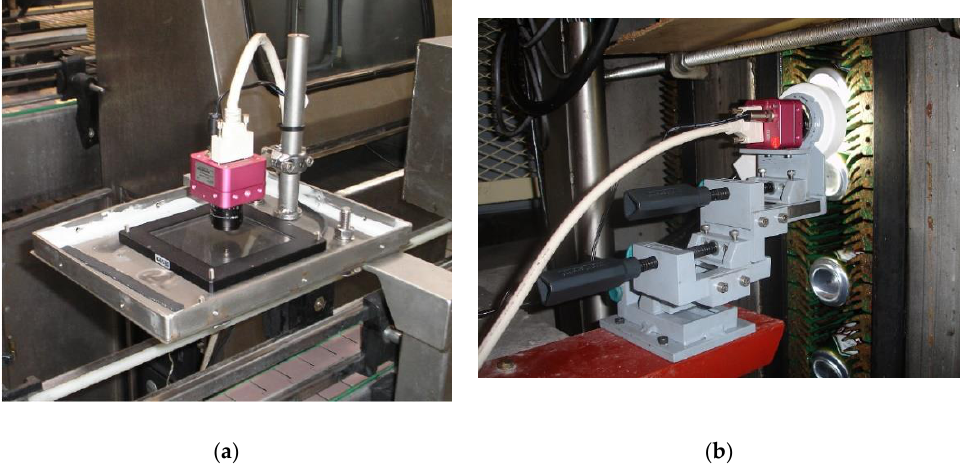
Figure 1. Image acquisition devices on a conveyor belt with a frame rate of 200 (black and white) images per second for ( a ) ground-plane line and ( b ) vertical plane.